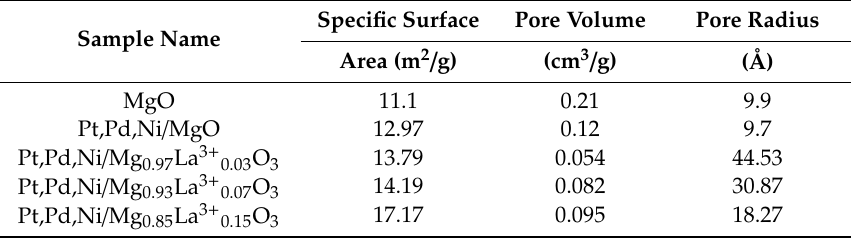
Table 3. The main textural properties of the fresh